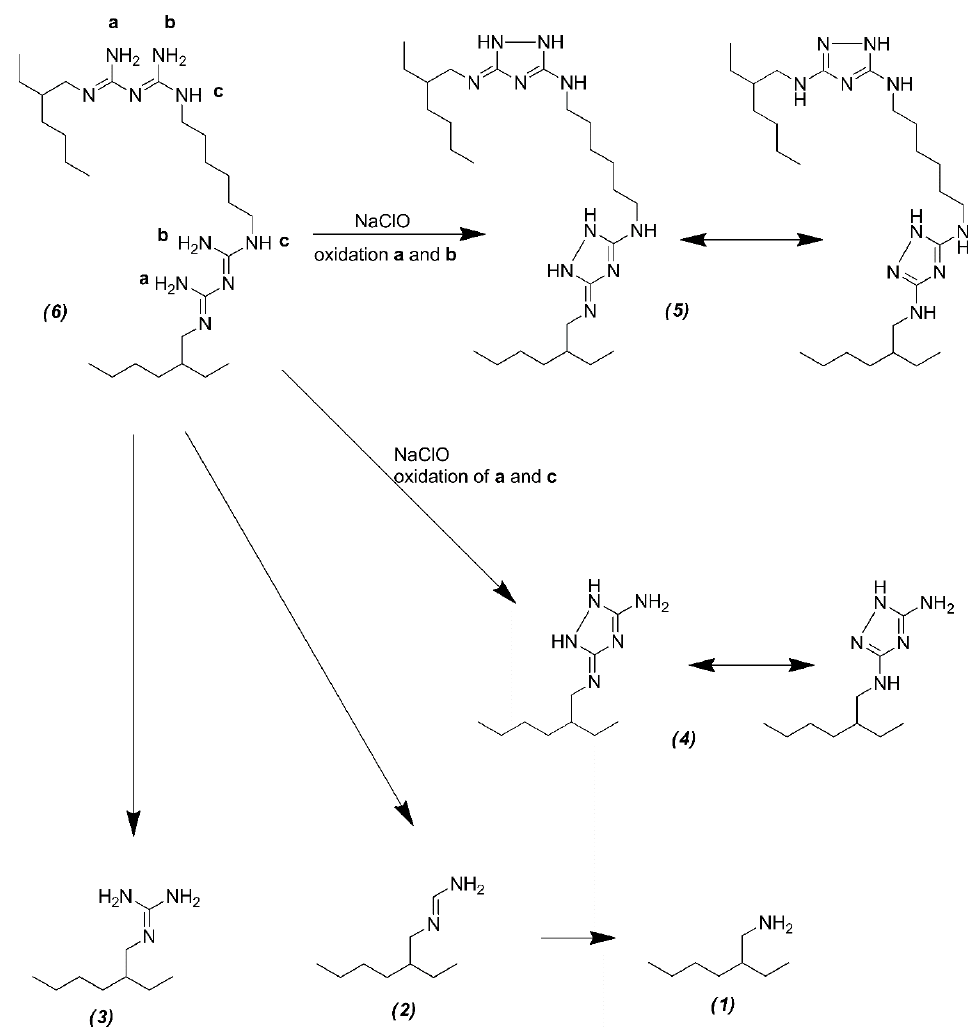
Figure 3. The scheme of possible reactions between ALX and NaOCl (numbers in the brackets correspond with the numbers from Table 1). Letters a, b, c and label nitrogen atoms in the amino groups of guanidine moieties in ALX molecule. The relative reaction rates of the products depending on the concentration of NaOCl reagent have also been investigated and elaborated as the percentage of a particular peak area among investigated compounds (ALX has been skipped due to significantly higher values; see Supplementary Materials Figure S2).